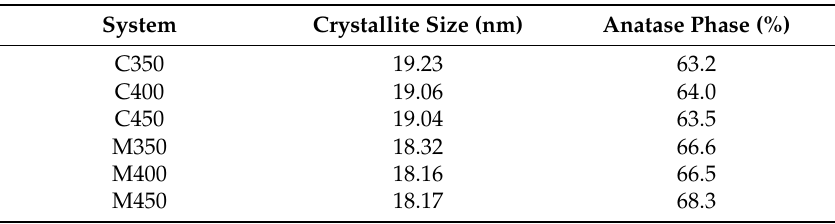
Table 1. XRD parameters of the titania